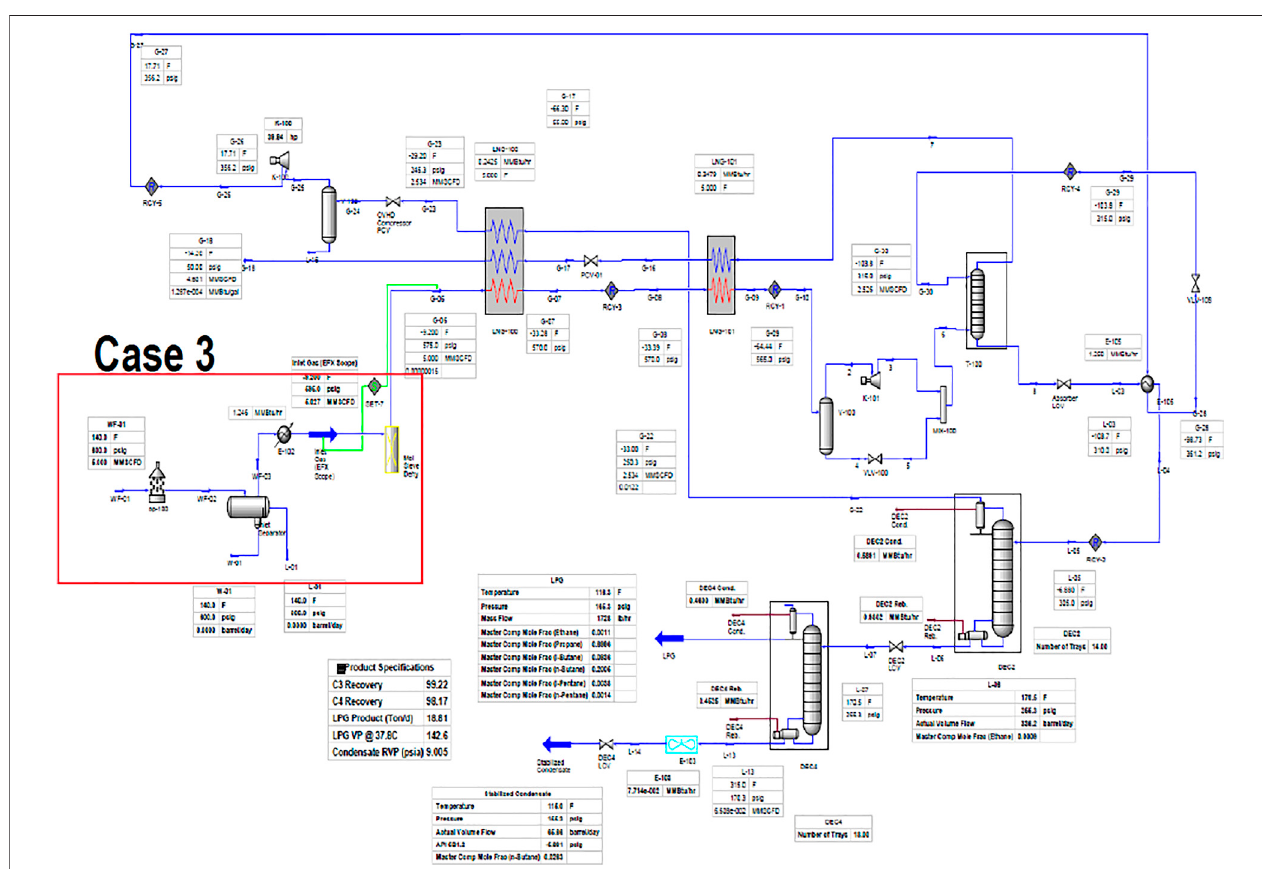
FIGURE 5 | Process fl ow diagram and Aspen HYSYS model for case study 3.